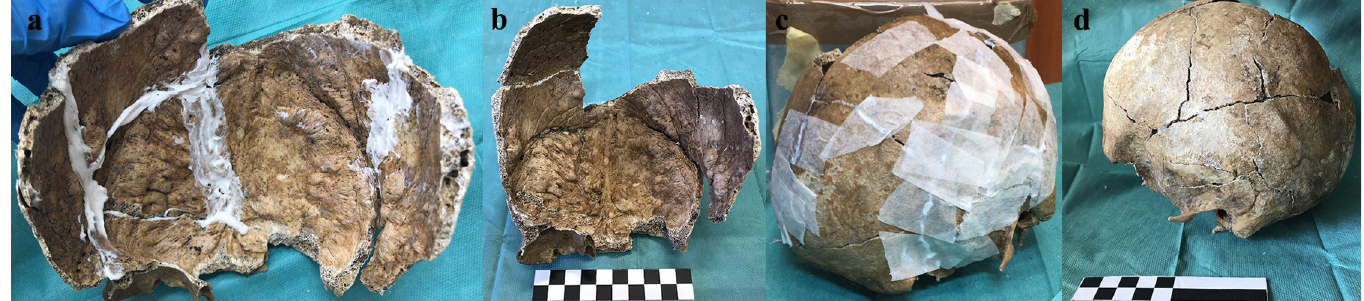
Fig 1. a. The skull at the moment of its discovery; b. The skull during the correct restoration; c. The final stage of the restoration process; d. The completely restored skull.